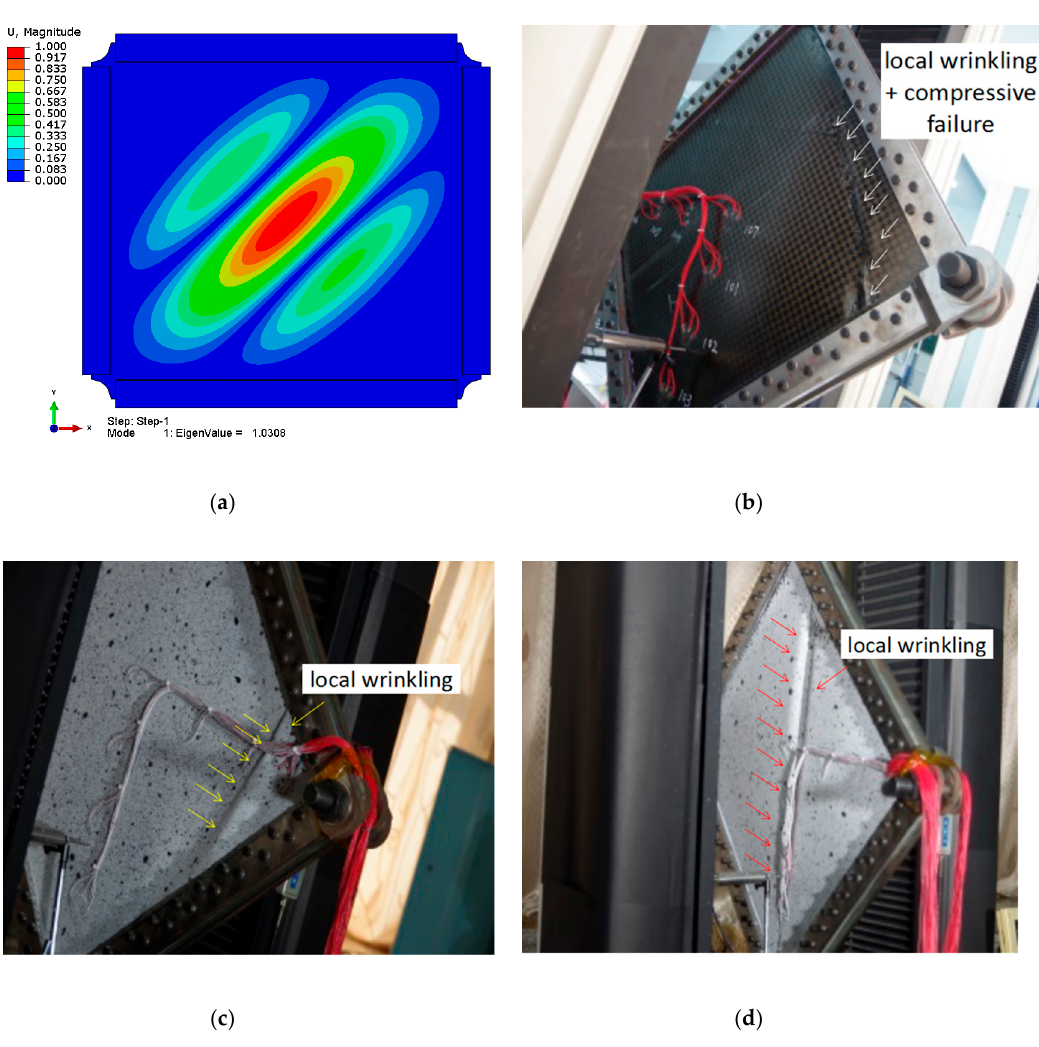
Figure 21. Buckling and failure mode: ( a ) first mode calculated by FEM; ( b ) failure modal of 01# sample; ( c ) failure modal of 02# sample; ( d ) failure modal of 03# sample.